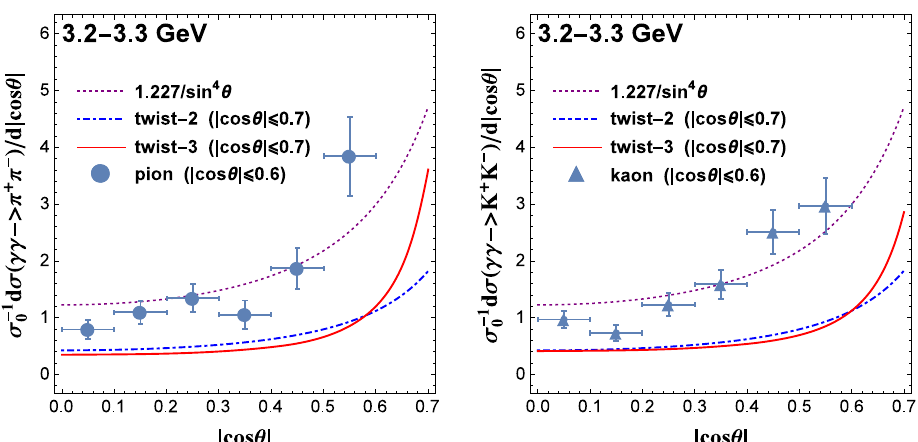
Fig. 6 Angular dependence of the cross section, σ − 1